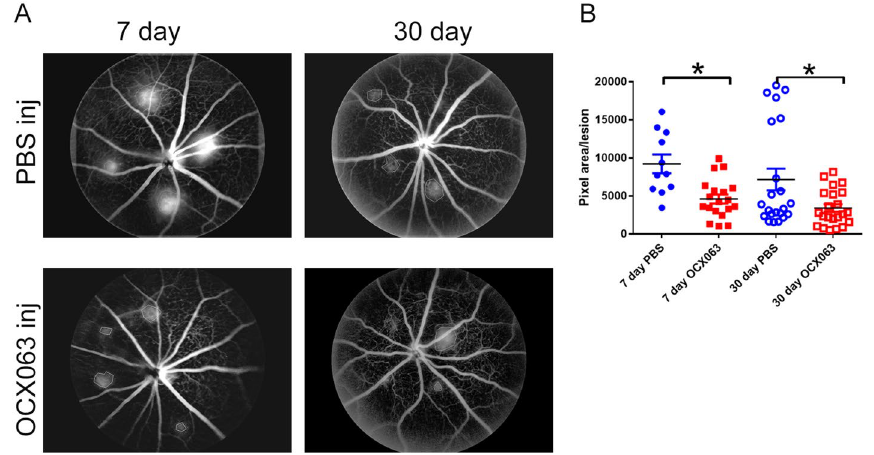
Figure 5. OCX063 reduced fluoresceine leakage 7-days and 30-days following laser induced CNV. ( A ) Grey scale fundus images that show leakage size is smaller in OCX063 injected mice compared to sham (PBS) injected eyes at 7- and 30-days post laser induced CNV. Upper panels are PBS injected eyes. Lower panels are OCX063 injected eyes. ( B ) Graph showing pixel area/lesion was statistically smaller in OCX063 injected mice (red squares filled: 7 days, red square outline: 30 days) compared to PBS injected eyes (blue circles filled: 7 days, blue circles outline: 30 days). x-axis is treatment groups and y-axis is pixel area/lesion. Error bars ± SEM, *p < 0.05 Tukey’s post-hoc following one-way